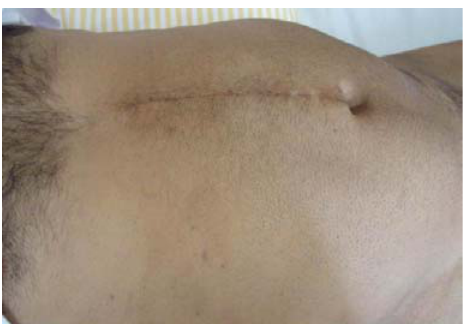
Figure 5 - Esthetically pleasing belly with no rectus abdominis diastasis and no umbilical hernia after bilateral nephrectomy for